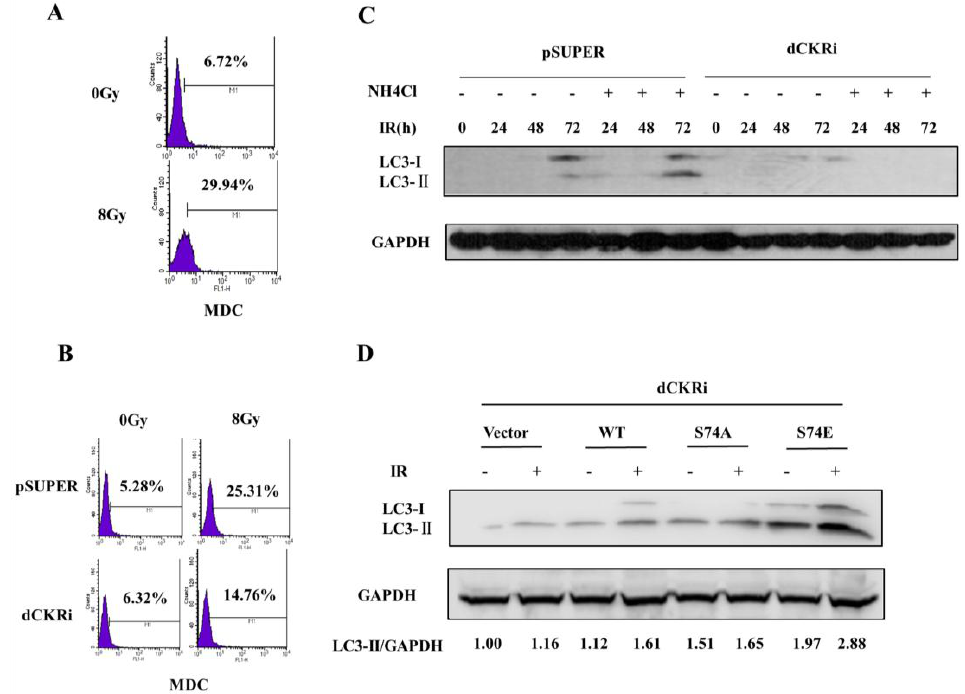
Figure 3. dCK promoted IR-induced autophagy in HeLa cells. ( A ) HeLa cells were treated with